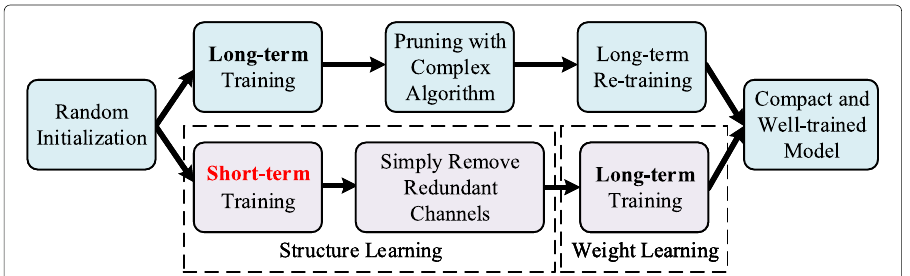
Fig. 2 The comparison of conventional pruning process (upper) and our proposed one (lower). We divide the original training and pruning procedure into two phases, that is, the short-term structure-learning and the long-term weight-learning